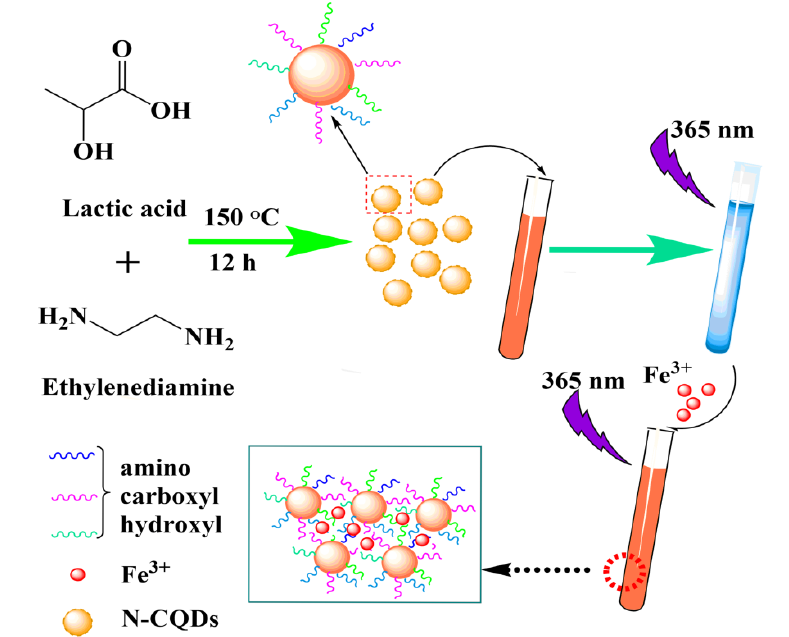
Scheme 1. Schematic illustration of one-step manufacturing for N-CQDs and the detection of Fe 3+ using